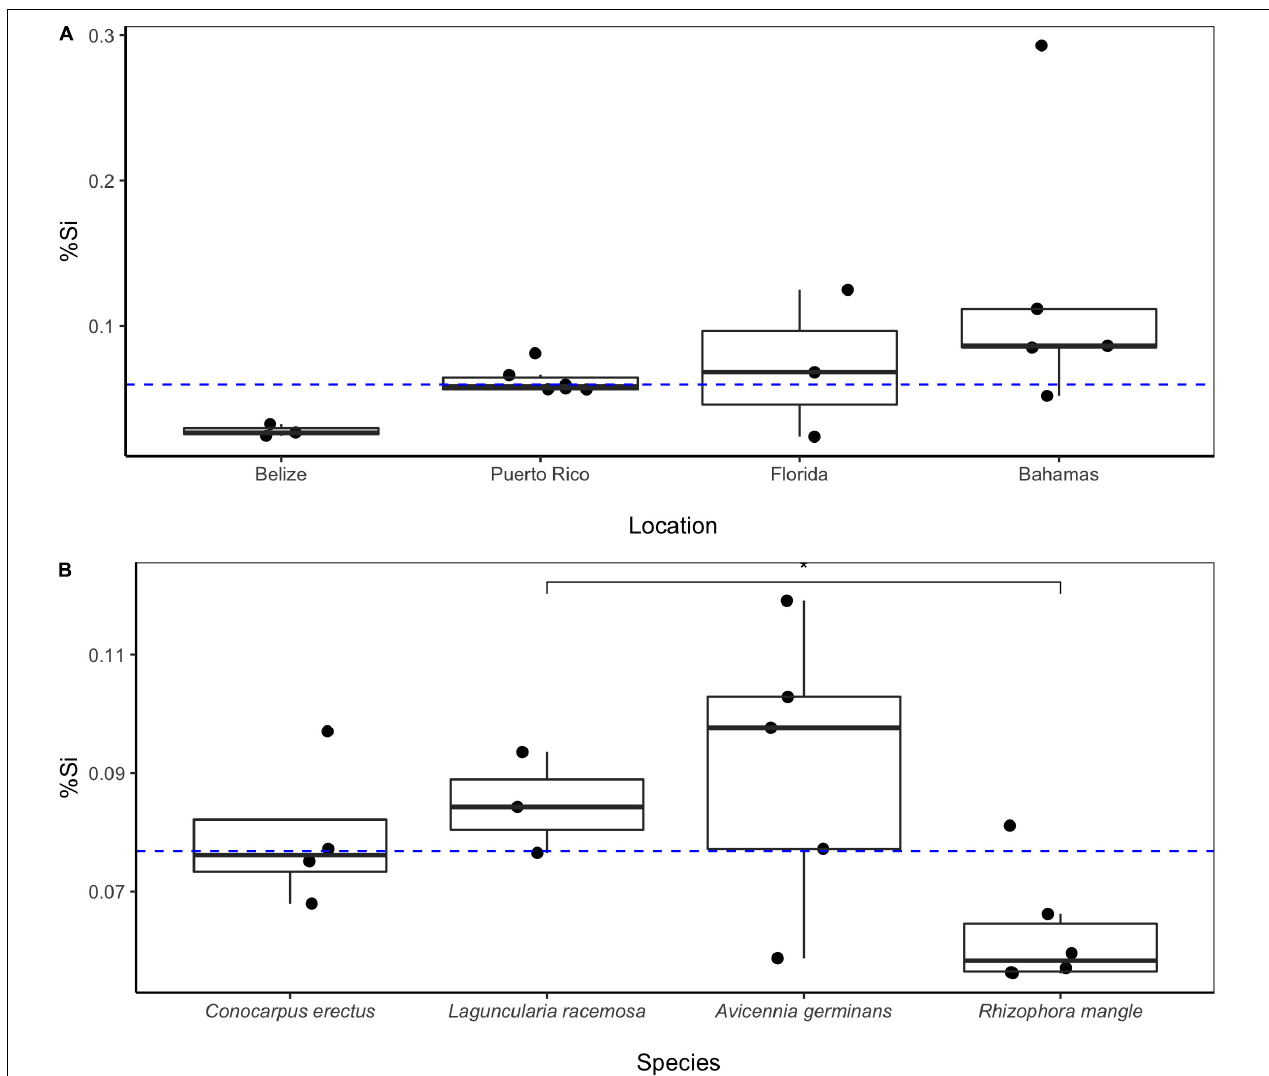
FIGURE 2 | Foliar Si concentrations (as %Si) of Rhizophora mangle (red mangrove) are not significantly different across the four sampling sites ( p = 0.0686). Median foliar %Si (dashed blue line) for Rhizophora mangle was 0.06 ( ± 0.04 median absolute deviation). (A) Foliar Si concentrations (as %Si) for four mangrove species from Puerto Rico. (B) Laguncularia racemosa Si concentrations are significantly ( p = 0.048) higher than Si concentrations observed in Rhizophora mangle . Median foliar %Si (dashed blue line) for mangroves in Puerto Rico was 0.07 ( ± 0.02). Mangroves are listed in order of the generally observed zonation patterns from inland to